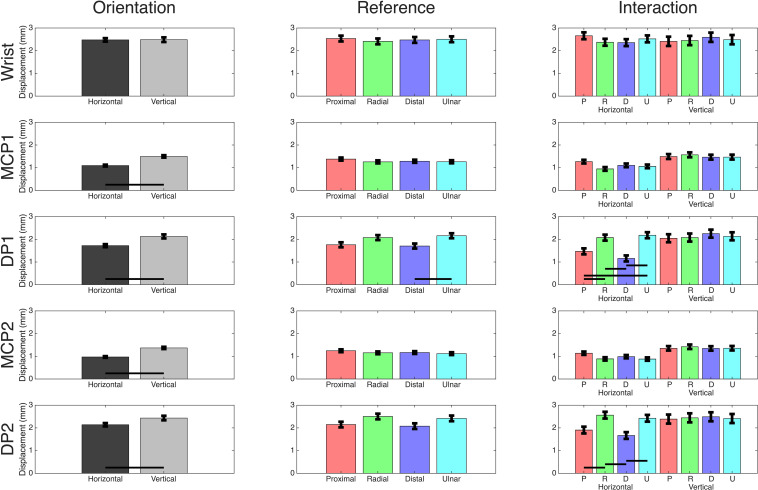
Motion capture comparisons. Mean values for each two-way ANOVA performed on the motion capture marker’s two-way ANOVA using orientation and primary stimuli as effects. Black bars indicate a significant post hoc Tukey-Kramer result of p<0.05. Comparisons between orientations in the interaction plots are removed as they are not of interest, but significant results between references movements within orientation are shown.